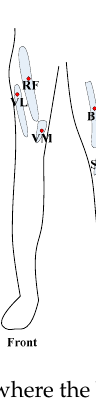
Figure 5. The body parts and points where the bi-polar surface electrodes were